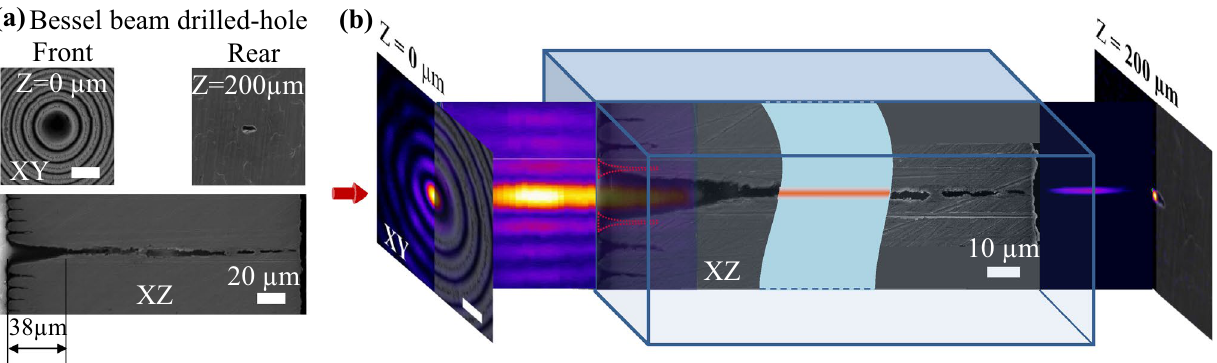
Figure 5. ( a ) SEM images of the hole drilled through the 200 μm steel plate by the Bessel beam at the laser 5.15 J/cm 2 . Upper images show top-view surfaces of the hole front whose topography resembles fluence F = 0 ) hole diameter of the arrangement of the concentric lobes of the Bessel beam profile, with an entrance ( Z = 200 ), with an average diameter of 7 μm. The lower image displays the cross- 24 μm and the hole rear ( Z = ∼ ∼ 38 μm. ( b ) Matching sectional profile of the hole along the longitudinal axis Z , with a tapering distance of ∼ of the Bessel beam profiles to the surface topography of the drilled hole. Ablation occurred at not only the 0th-order central lobe but also the 1st-order side lobe. Higher-order side lobes are equally leaving isolated traces. Imaginary drawing (the red-dot line region) was supposed for the ablated shape of the 1st-order side-lobe. However, the actual tapering shape indicates a bend of the 1st-order side-lobe toward the center. A replicated version of the Bessel beam is suggested to be formed and drills through the plate. The replicated Bessel beam profile was captured after exiting the drilling-through